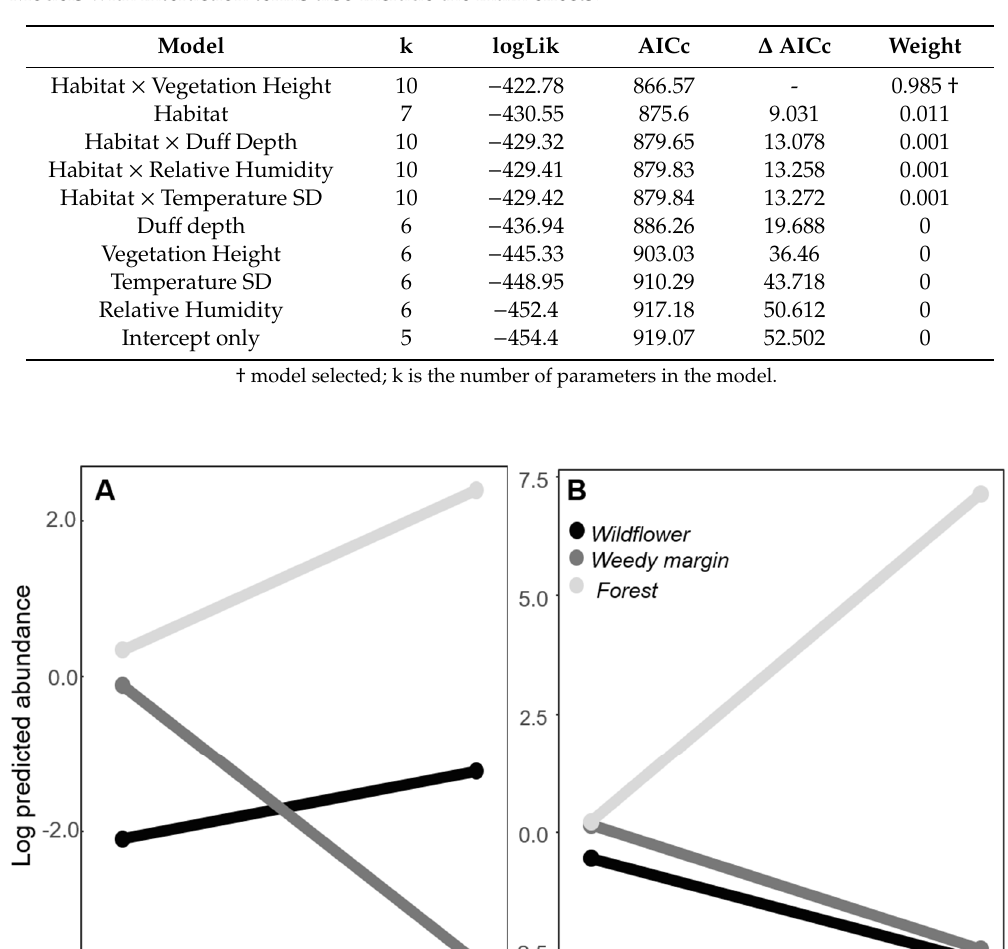
Table 5. Model selection for environmental variables a ff ecting the abundance of A. americanum nymphs. Models with interaction terms also include the main e ff ects.